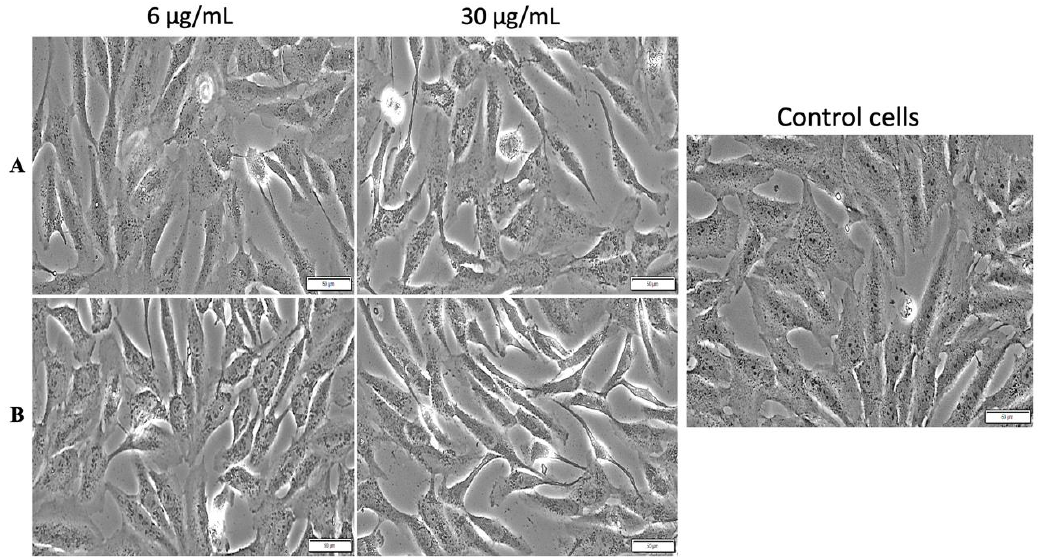
Figure 13. Morphology of MCF-10A cells after treatment with MCS under standard ( A ) and hyperthermic conditions ( B ). Phase contrast pictures were taken 24 h post-incubation, at a magnification of 20×. Scale bars represent 50 µm.